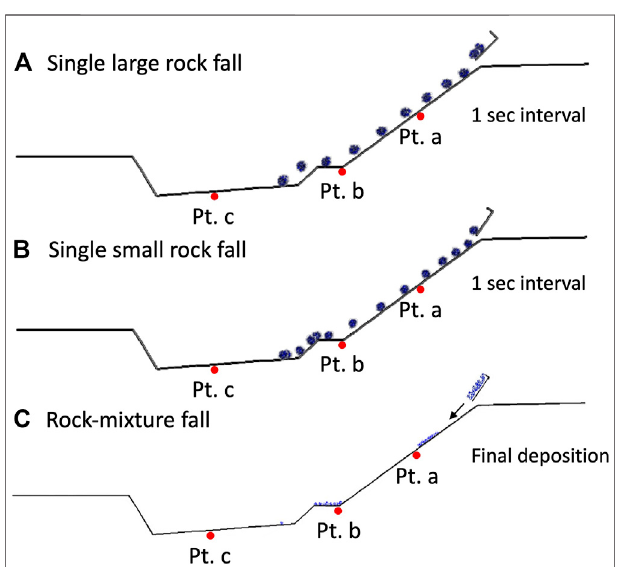
FIGURE 3 | Schematic of PFC models for the tests. Pt. (a – c) are the monitoring points in FLAC. The particle traces shown are in 1 s interval for the rock block falls and the fi nal deposition for rock mixture fall.